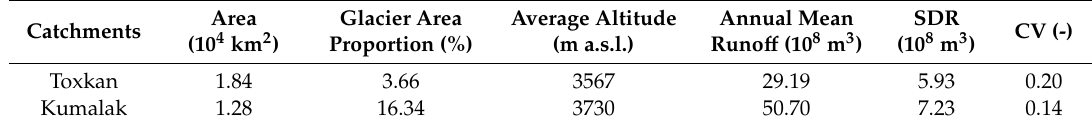
Table 1. Characteristics of runo ff in the Toxkan and Kumalak River catchments during 1979–2015. Catchments